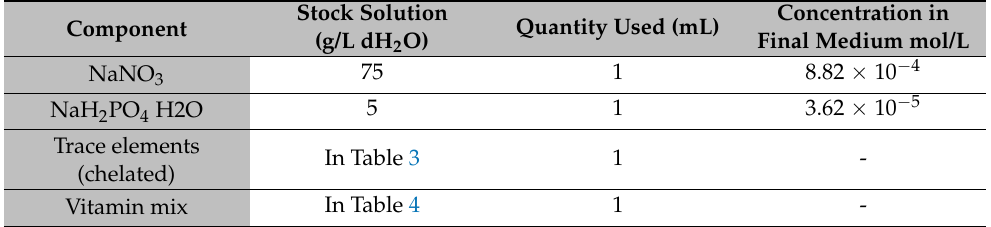
Table 3. Metal solution.